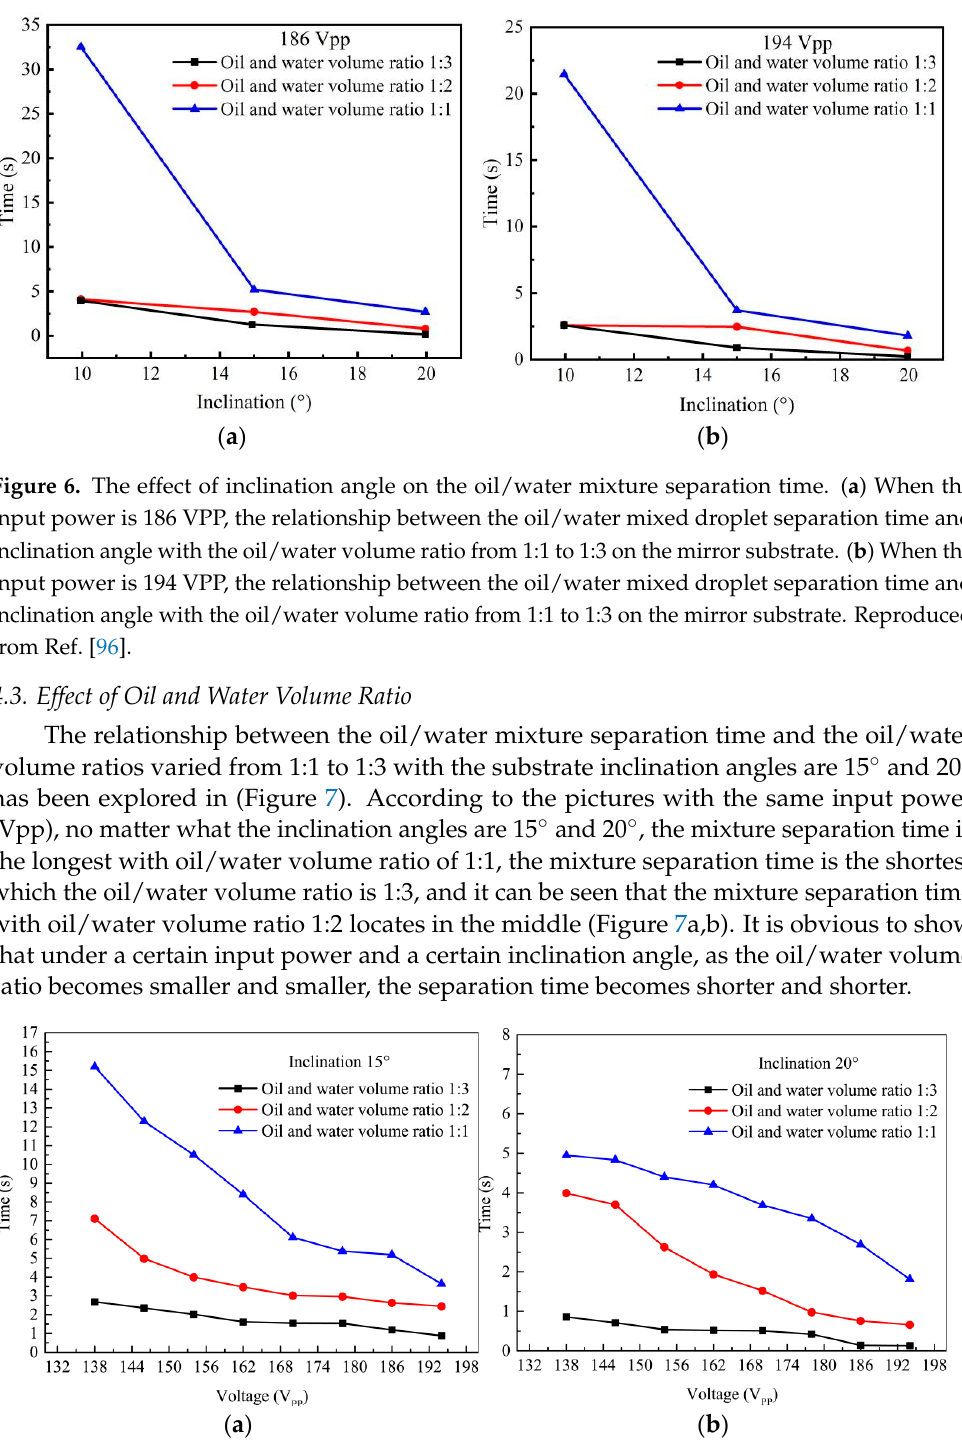
Figure 7. The oil/water mixed droplet separation time with the oil/water volume ratio from 1:1 to 1:3. ( a ) The oil/water mixed droplet separation time with the oil/water volume on the mirror substrate inclination angle is 15°. ( b ) The oil/water mixed droplet separation time with the oil/water volume on the mirror substrate inclination angle is 20°. Reproduced from Ref. [96].